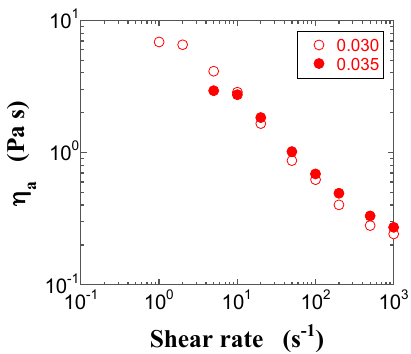
Figure 6. Double-logarithmic plots of the apparent steady-state shear viscosities for the PS suspensions at φ = 0.030 (open red circle) and 0.035 (filled red circle) as a function of the shear rate.